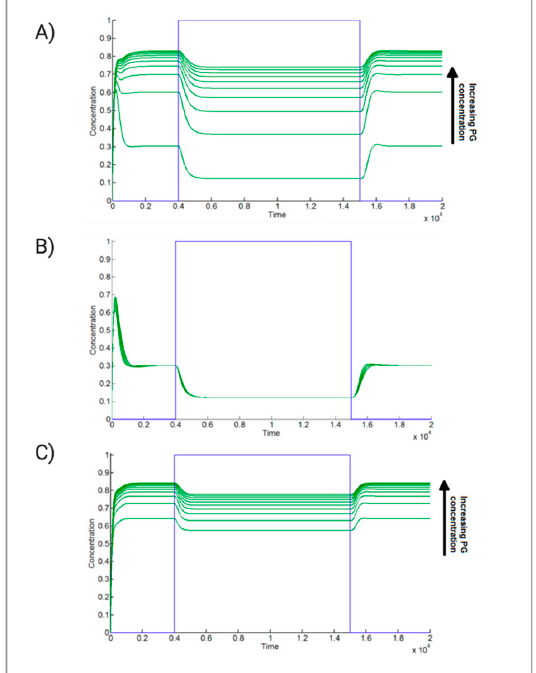
Figure 1. Trend of “adipogenic mRNA” expression at different concentrations of Plakoglobin (PG). ( A ) To increasing concentrations of PG (0, 56, 111, 167, 222, 167, 222, 278, 333, 389, 444, and 500 nM), it corresponds an increased level of “adipogenic mRNA”. The model takes into account a regulatory feedback for TCF synthesis and a mechanism of double competition between β -catenin and PG (they compete in both unbound and TCF-bound states). ( B ) Simulations of the model based on single competition between β -catenin and PG for the binding to TCF (no transcriptional competition between TCF-bound complexes). ( C ) Simulations of the model based on β -catenin/PG competition for TCF-binding and without TCF synthesis regulatory feedback loop (the initial concentration of free TCF is set to 15